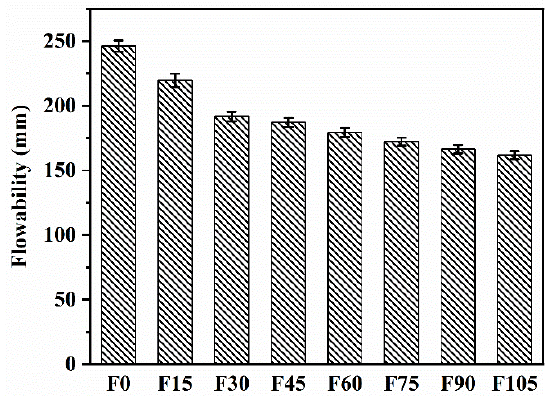
Figure 5. Flowability of F0–F105.